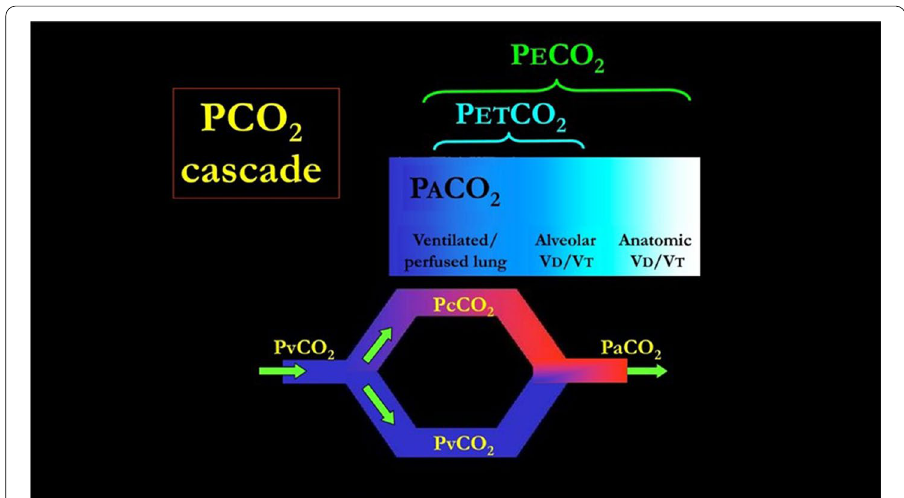
Fig. 4 The PvCO 2 decreases to PcCO 2 (the capillary PCO 2 pressure) after releasing CO 2 in the alveolar space. The partial pressure of CO 2 in the alveoli (PACO 2 ) which are perfused is equal to PcCO 2 . This pressure represents the “ideal” alveolar gas, as it derives from pulmonary units which are both perfused and ventilated. This model ignores other factors possibly affecting the CO 2 dynamics, such as the CO 2 production from the inflammatory cells residing in the inflamed lung. Actually, this ideal PACO 2 may be “diluted” by the gas coming from unperfused but ventilated alveoli (alveolar dead space). The PACO 2 then becomes P ET CO 2 . In turn, the P ET CO 2 may be diluted into the gas ventilating the airways and the apparatus (anatomical dead space) becoming P ET CO 2 . It must be realized that the number of molecules of CO 2 involved are exactly the same, but their concentration (and partial pressure) depends on the progressive dilution with alveolar gases and “anatomical” gases. In normal individual, PACO 2 and P ET CO 2 differ only of 1–2 mmHg, being the alveolar dead space negligible. The PvCO 2 may also reach the arterial circulation without any modification in presence of venous admixture. In this case, PaCO 2 is the result of mixing between PcCO 2 and PvCO 2 . Greater is the venous admixture, greater is the difference between PaCO 2 (higher) and PcCO 2 . In the perfect gas exchanger,